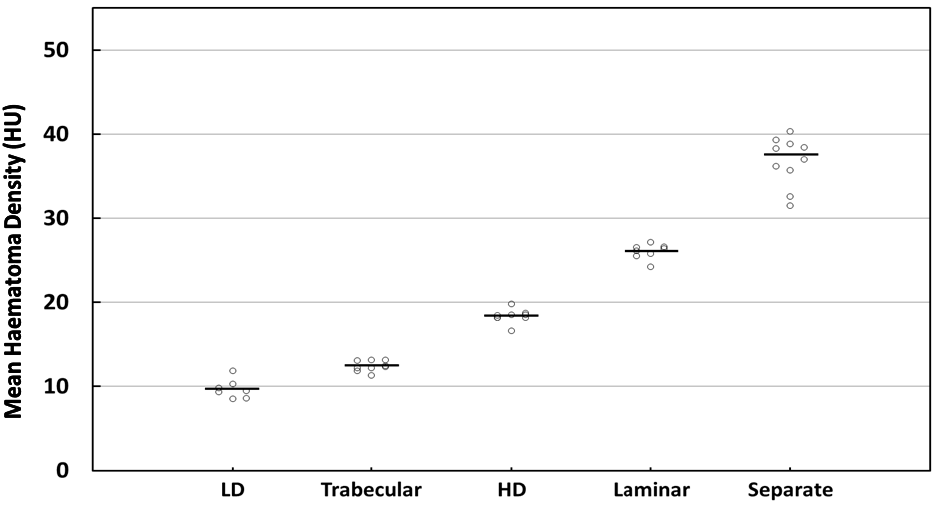
Figure 5. The distribution of MHD across five types of CSDHs based on internal structure. The dots indicated individual observations and the horizontal bar represents the median.